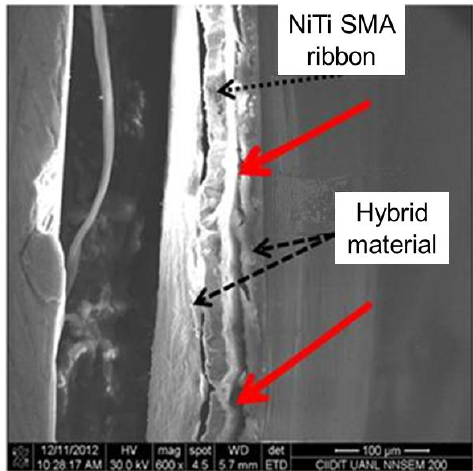
Figure 4. Transversal SEM view of the composite material at the union between the magnetic hybrid material and the NiTi ribbon. Red arrows show where adhesion is not fully